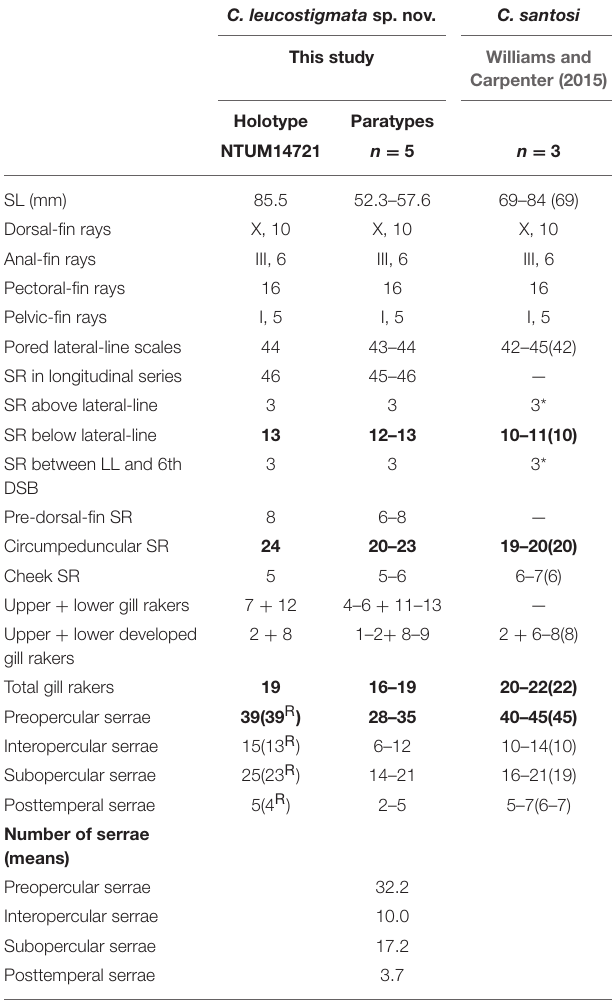
TABLE 1 | Meristic features of Chelidoperca leucostigmata sp. nov. and C. santosi from references; bold font presents distinguishing characteristics; parentheses in Williams and Carpenter (2015) contains holotype